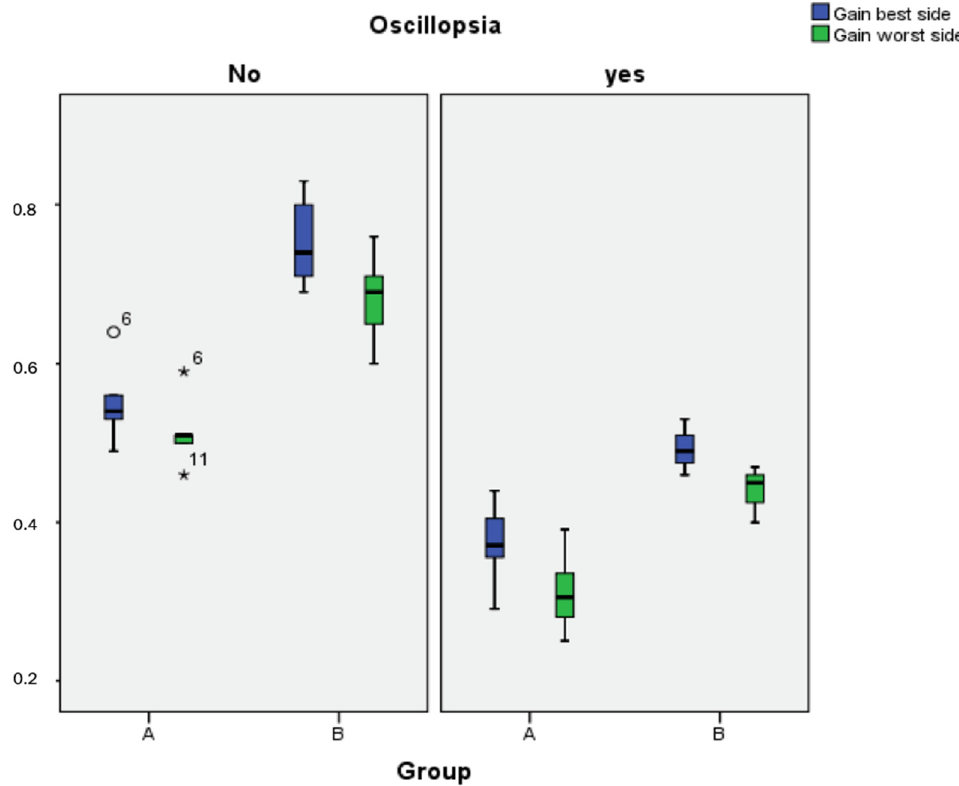
Figure 2. Patient gains and the presence of oscillopsia. Regardless of the group (A or B), the presence of oscillopsia is related to the low gain of the vestibulo-ocular reflex (* Atypcal values). If we compare the patients in group A with the worst patients (patients with the worst vestibular function) in group B (the worst 20% of the patients), it is observed that